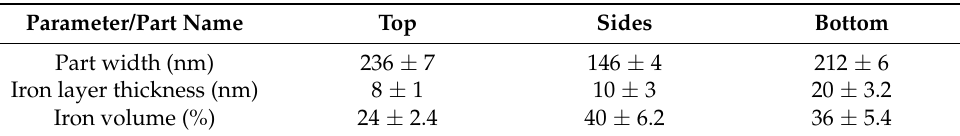
Table 1. The width and corresponding thicknesses of the iron layer obtained by TEM images. The iron volume values correspond to the amount of iron in each separate part with respect to the total iron volume deposited into the single period of a